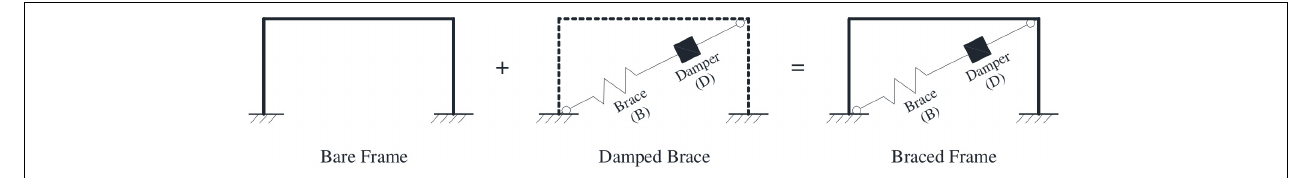
FIGURE 1 | Schematization of the bare frame, damped brace, and braced frame